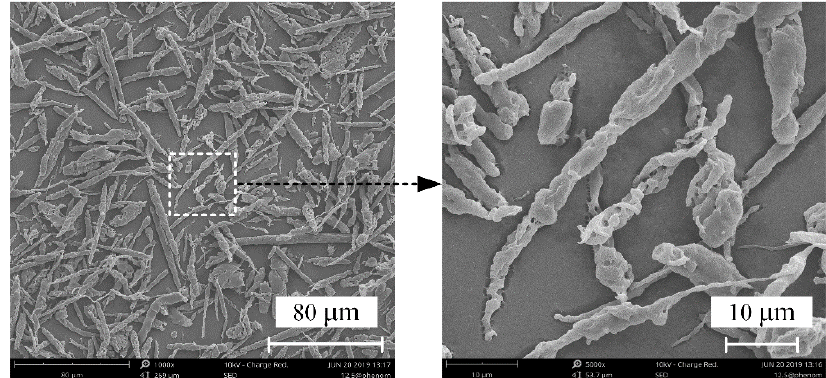
Wear debris of polyformaldehyde